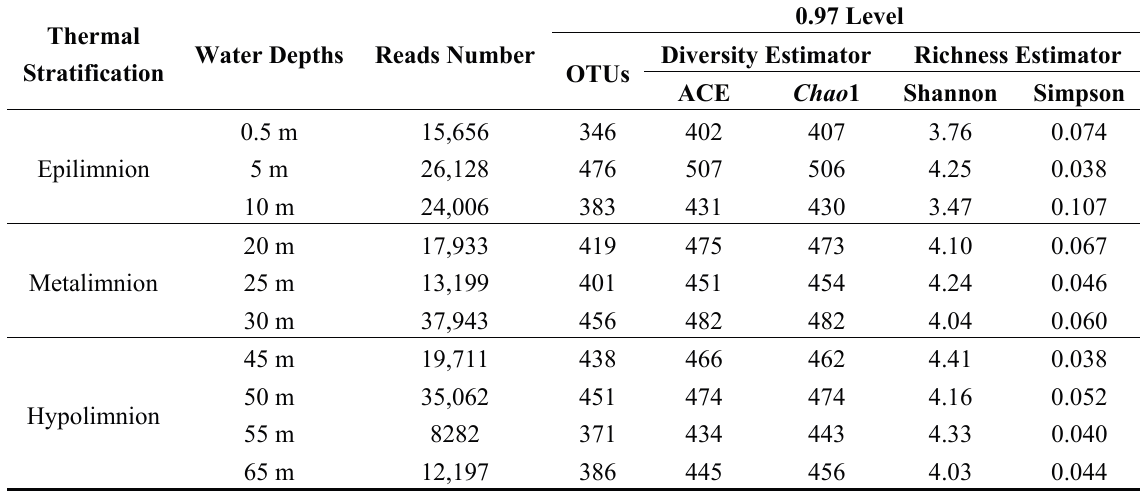
Abbreviation: ACE, abundance based-coverage estimator. OTUs, operational taxonomic units. The water bacterial community diversity estimators were calculated on 210,117